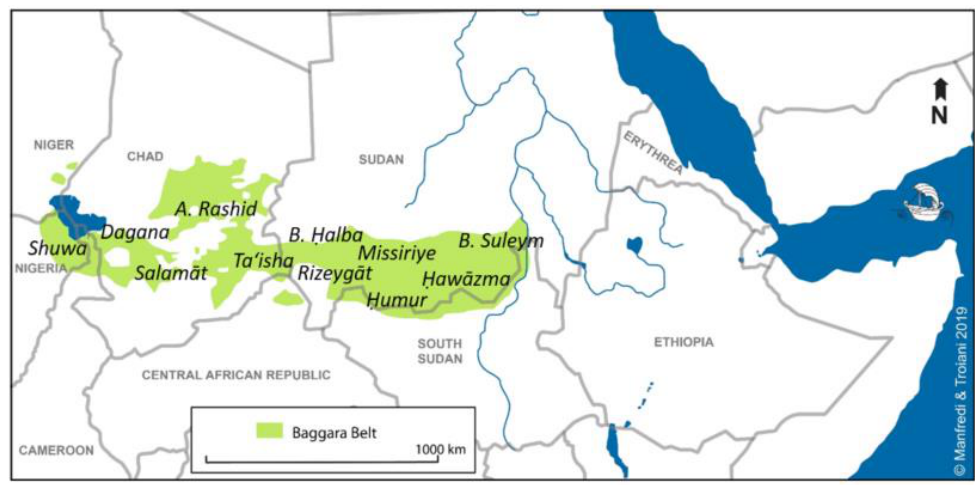
Figure 1. The Baggara Belt and its main